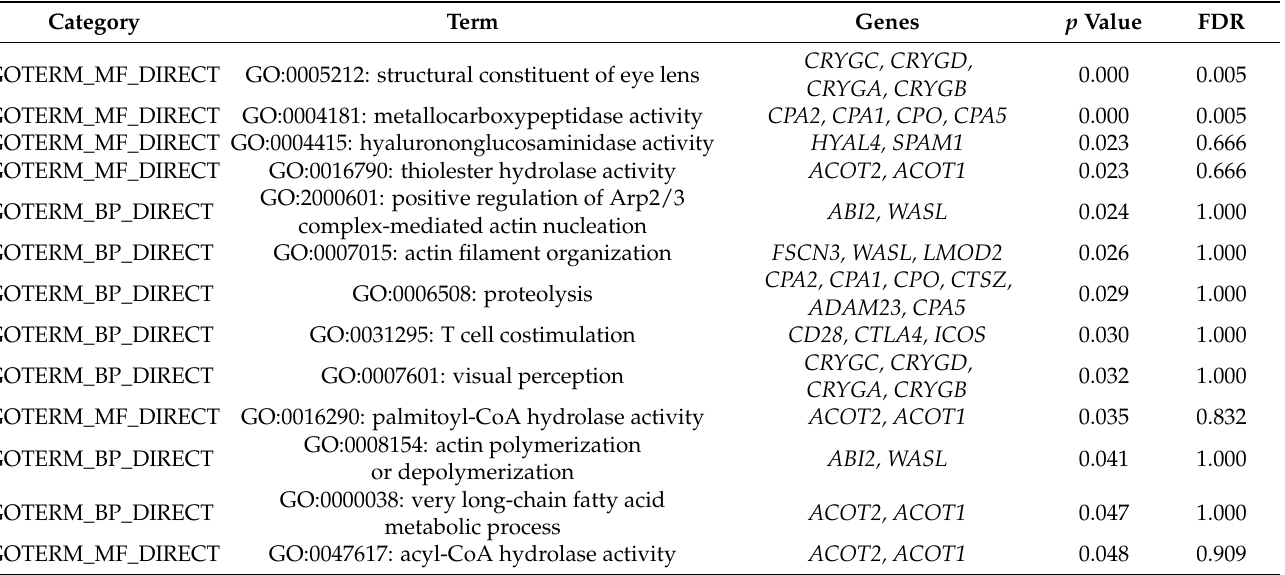
Table 4. Enriched GO TERMS determined by DAVID from genes identified in selection regions specific to the BAL breed using XPEHH. Please note that GOTERM_MF refers to molecular function and GOTERM_BP refers to biological